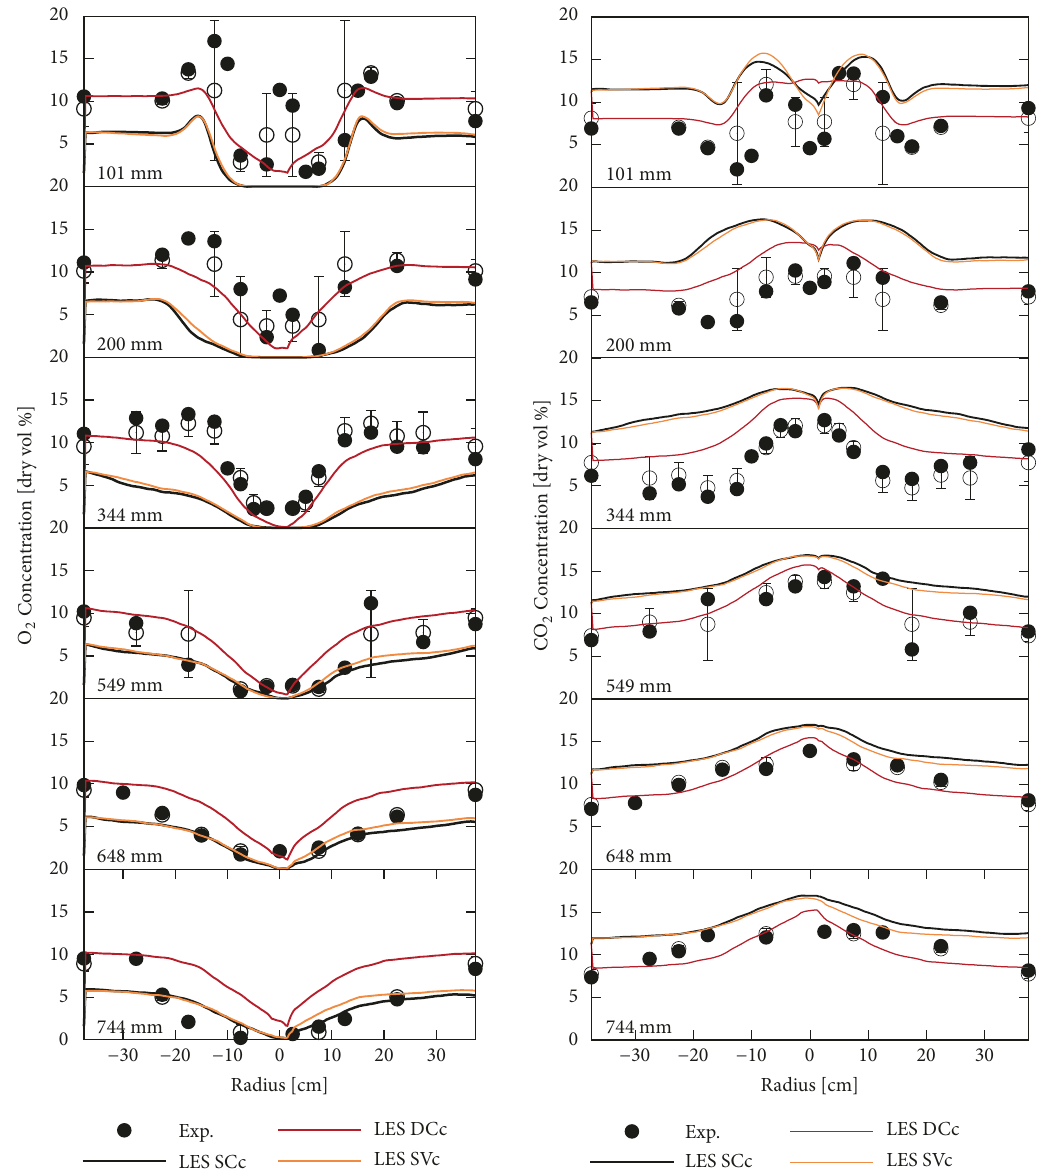
Figure12:ComparisonbetweenmeasurementsandpredictionsofO 2 (left)andCO 2 (right)forthemodellingcasesSCc,DCc,andSVc.Empty points and corresponding error bars show the mean and standard deviation of measurements performed at opposing, radially symmetric